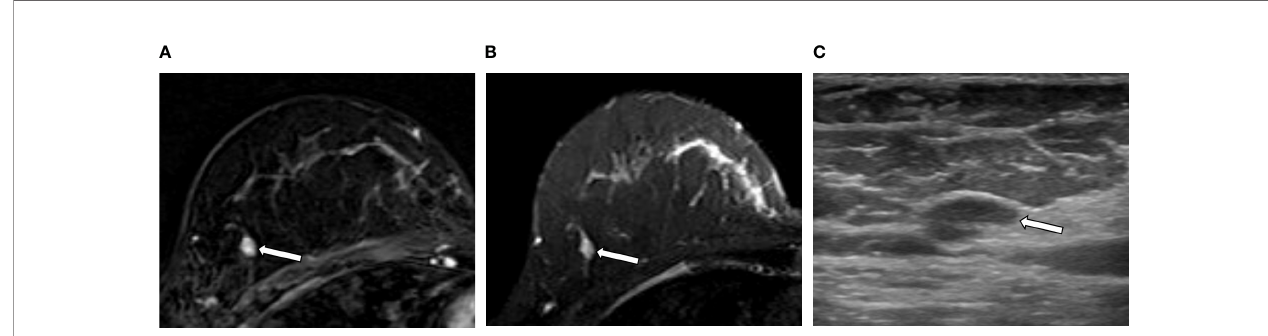
FIGURE 5 | An example of a false negative result by the radiomics analysis (RA) model in a 49-year-old woman with invasive carcinoma of no-special-type in the right breast. (A, B) A 0.7-cm oval circumscribed homogeneously enhancing mass (arrow) with slightly high signal intensity on T2-weighted image is seen in the different quadrant of the same breast [ (A) axial fi rst postcontrast T1-weighted image with subtraction; (B) axial T2-weighted image]. (C) Ultrasound image shows the corresponding oval mass with 0.7 cm in size (arrow). The RA model developed in this study categorized it as benign; however, the fi nal histologic analysis revealed ductal carcinoma in